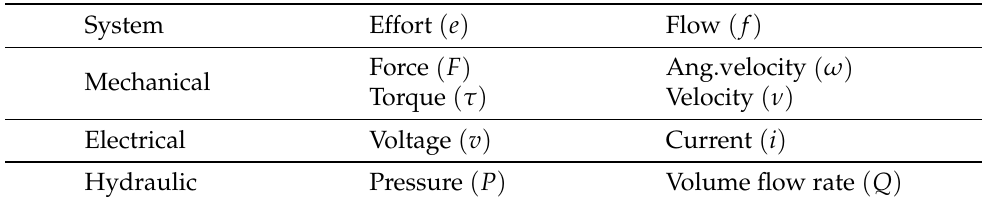
Table 1. Power variables.